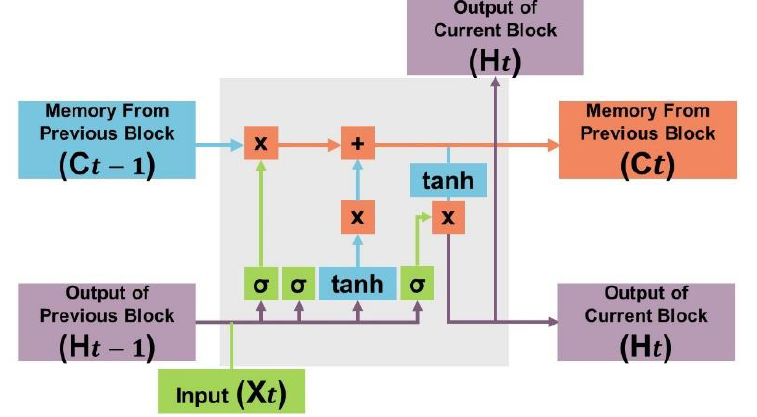
Figure 2. Schematic of a long short-term memory network ( σ : sigmoid function, tanh: hyperbolic tangent function, X: multiplication, +: addition). Source: Sezer et al. [14].